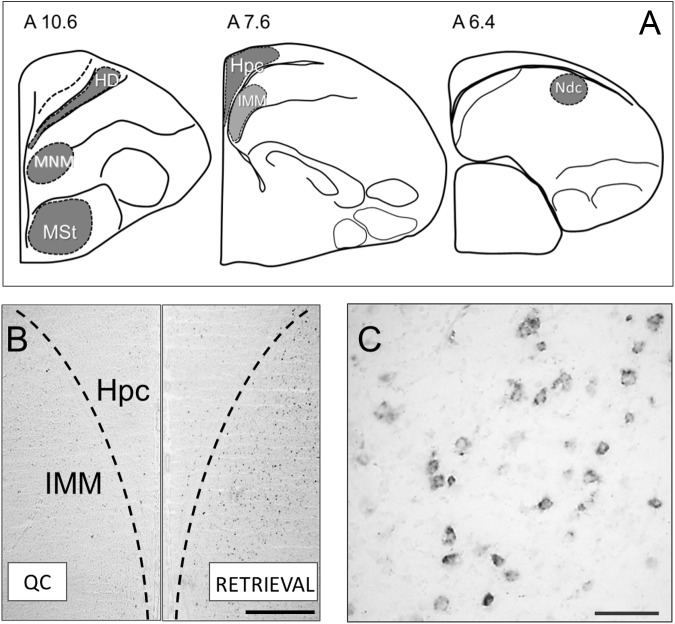
(A) Brain structures used for the c-fos expression analysis: HD, Hyperpallium densocellulare; MNM, Medio-rostral nidopallium/mesopallium (Maier and Scheich, 1983); MSt, Medial striatum; Hpc, Hippocampus; IMM, Intermediate medial mesopallium (Horn et al., 1983); Ndc, Nidopallium dorso-caudale (Metzger et al., 1998). (B) Micrographs showing representative c-fos mRNA staining in the brain of the untrained control chick (left half) and after memory retrieval (right half of the image). Scale bar = 500 μm. (C) Micrograph showing cytoplasmic c-fos mRNA staining at a higher magnification. Scale bar = 100 μm.